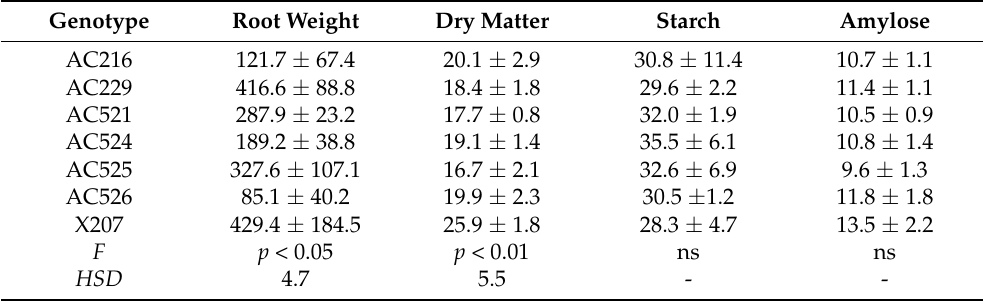
ns, not significant. Table 2. Sucrose and glucose contents in roots of six different accessions and the P. ahipa × P. tuberosus hybrid X207 (in % dry weight). Mean ± standard deviation. Significance of Snedecor’s F for the genotypic source of variation and Tukey’s HSD test.